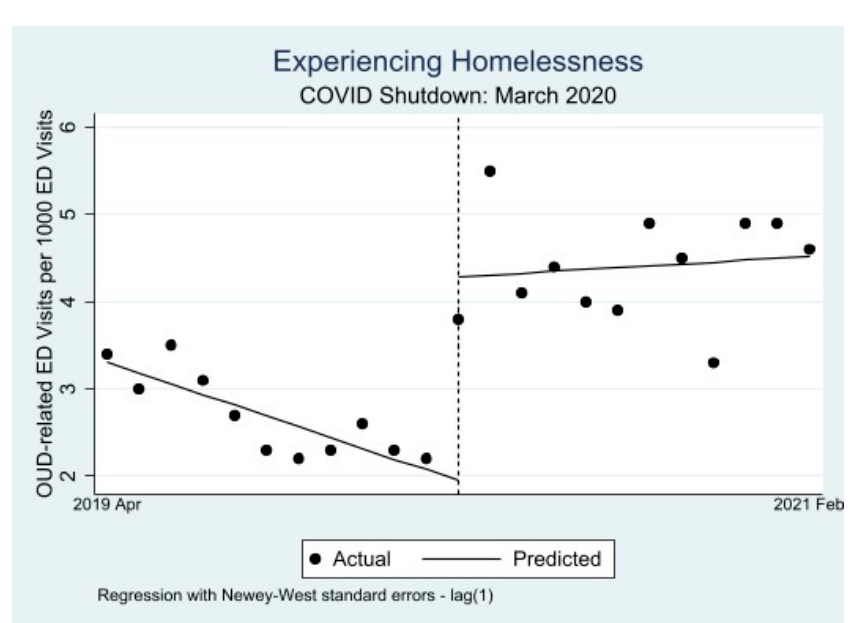
Figure A1. ITS Patients Experiencing Homelessness.